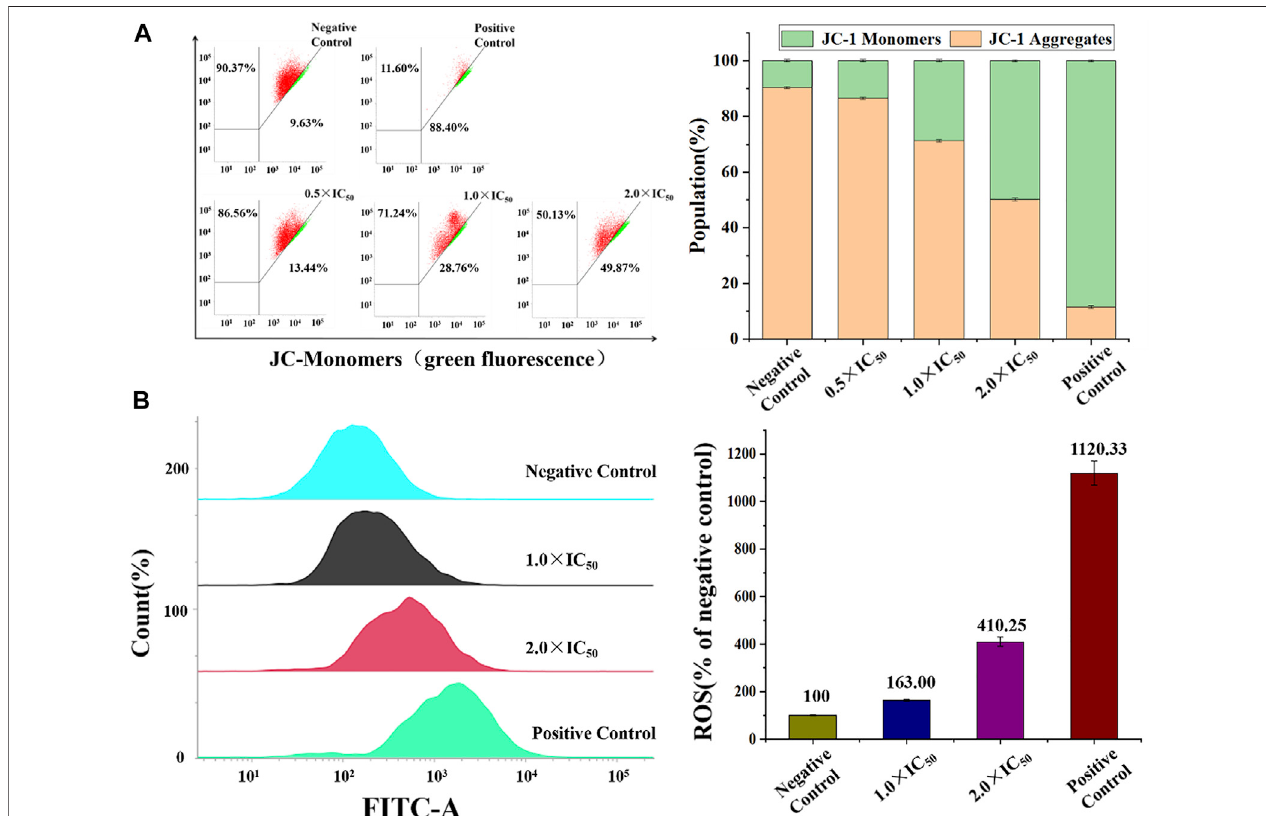
FIGURE8|(A) ThepercentageofA549cells(red)anddepolarizedA549cells(green)inA549cellsafterinducedbyIr2andstainedwithJC-1. (B) ROSinductionof A549 cells hatched with Ir2 at the concentration of 1.0 × IC 50 and 2.0 × IC 50 for 24 h. Data are quoted as mean ± SD of two replicates.